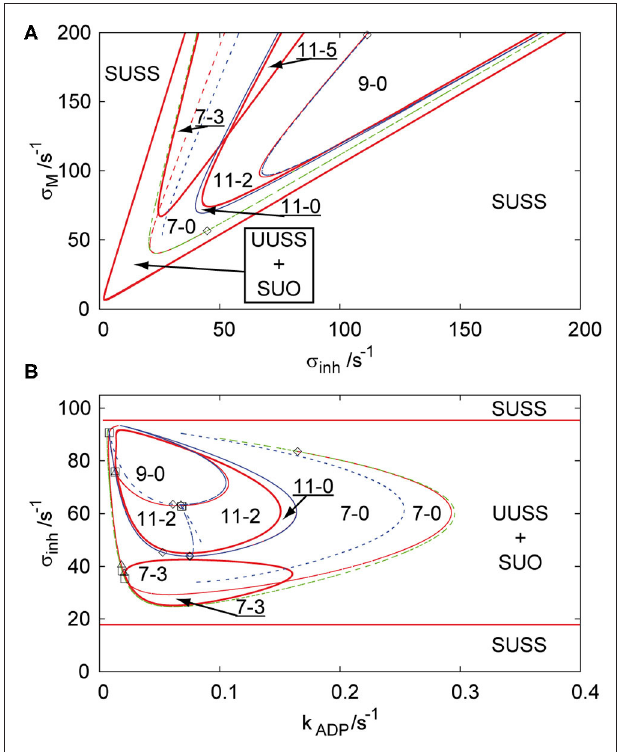
FIGURE 1 | Bifurcation diagram for three coupled cells in cyclic array, q = 1, in planes: (A) σ inh and σ M , k ADP = 0.1 s − 1 ; (B) σ inh and k ADP , σ M = 100 s − 1 . Red curve—Hopf bifurcation curve; blue curve—symmetry breaking bifurcation curve; green curve—limit point curve; full line—change of stability across the line, dashed curve—no change of stability across the line; empty square—intersection point of Hopf bifurcation/symmetry breaking bifurcation/limit point curves; empty diamond—Bogdanov-Takens bifurcation point; empty triangle—double Hopf bifurcation point; SUSS, stable uniform stationary state; UUSS, unstable uniform stationary state; SUO, stable uniform oscillations. Each parameter region is marked by a pair of numbers m,n, where m is total number of stationary states and n is the number of stable stationary